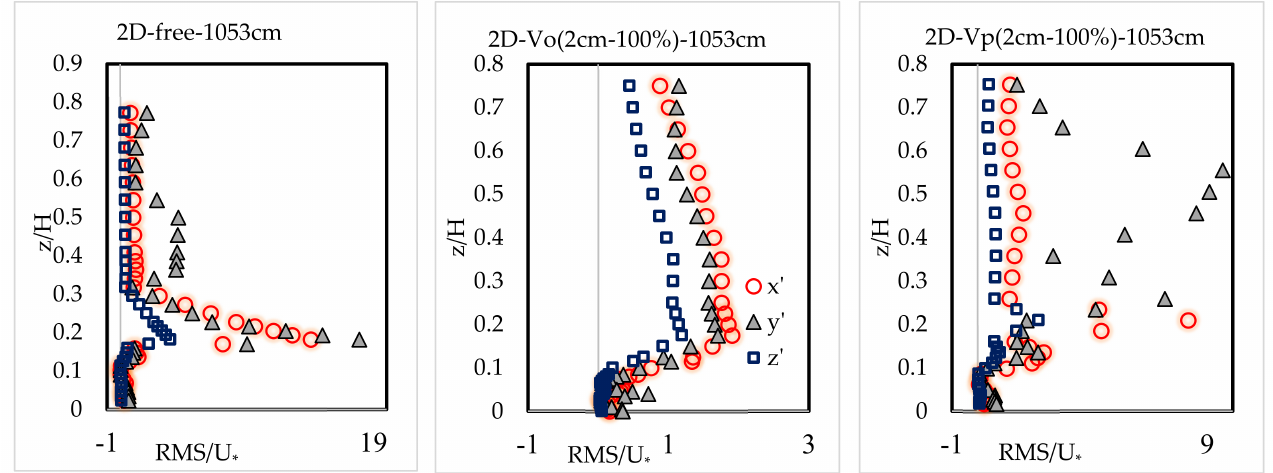
Figure 13. The vertical distributions of the Longitudinal, latitudinal, and vertical turbulent intensity components normalized by shear stress in the triple pile group with G/D =